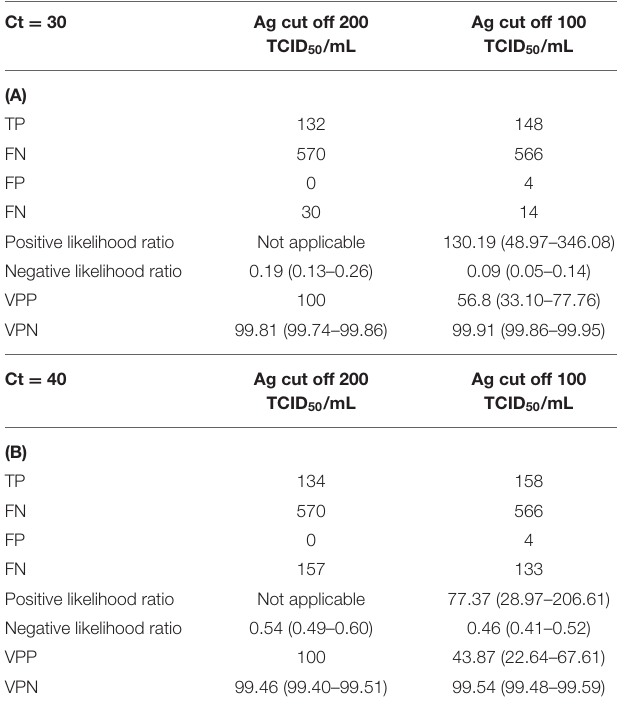
TABLE 1 | Sensitivity, specificity, negative predictive value, positive predictive value, and positive likelihood ratio for LIAISON ® SARS-CoV-2 antigen assay and (A) RT-PCR (Ct < 30) and (B) RT-PCR (Ct < 40) for the different cutoffs (200